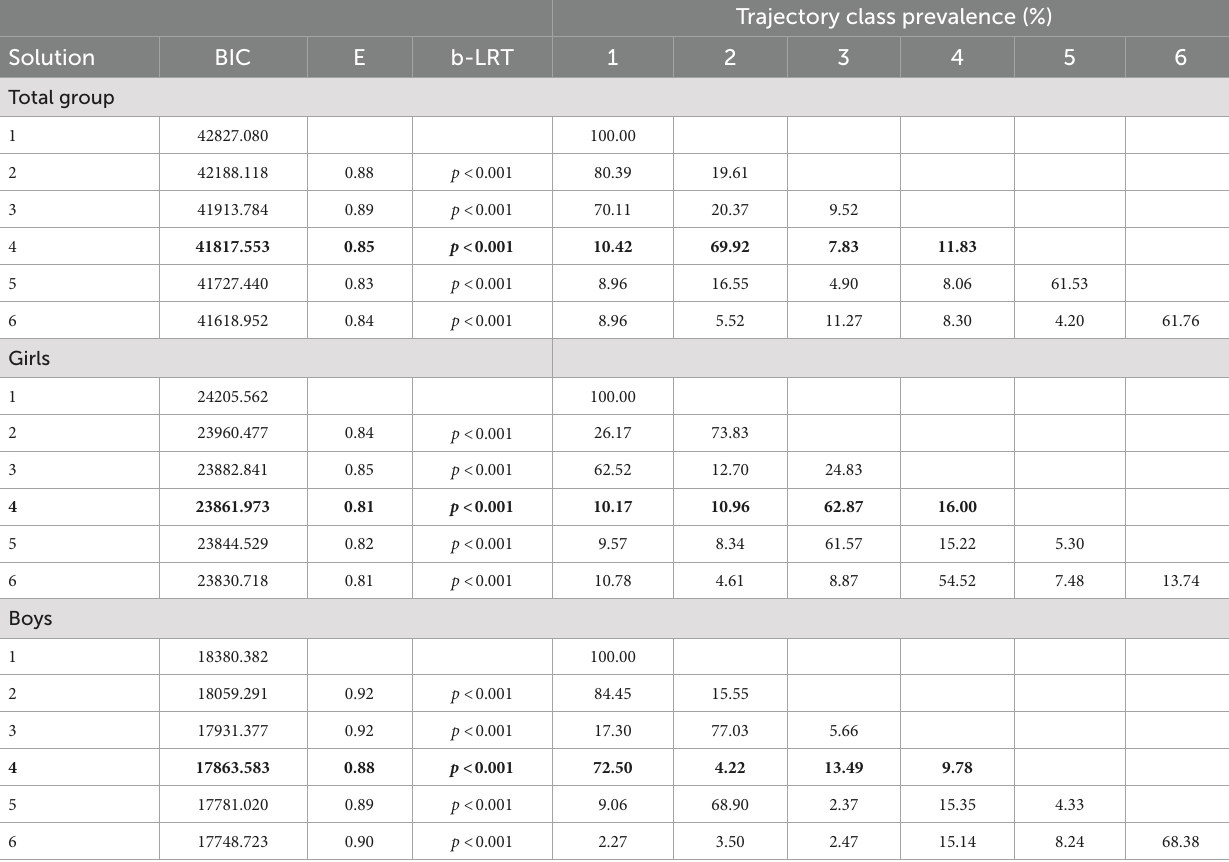
TABLE 4 Fit indices for different Growth Mixture Models for the total group, girls and